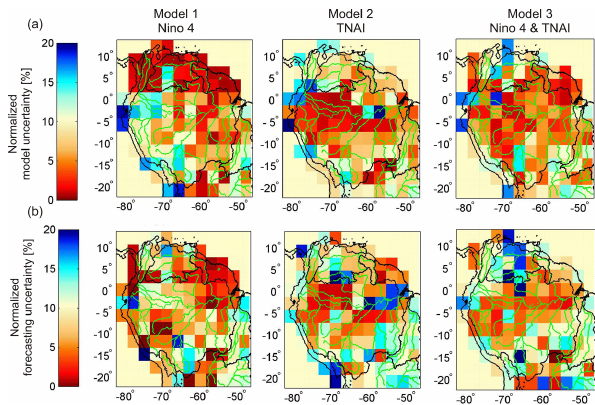
Figure 7. (a) Normalized model errors arising from uncertainties in the initial conditions for the three different models described in Ta- ble 1 (and with a 3-month minimum lead time). (b) Forecasting un- certainty defined as the NRMSE differences between the composite time series described in Sect. 3.3 and the model calibrated with the full 10-year time series (shown in Fig. 4). The total error is the sum of the forecasting errors (b) and the prediction error (Fig.